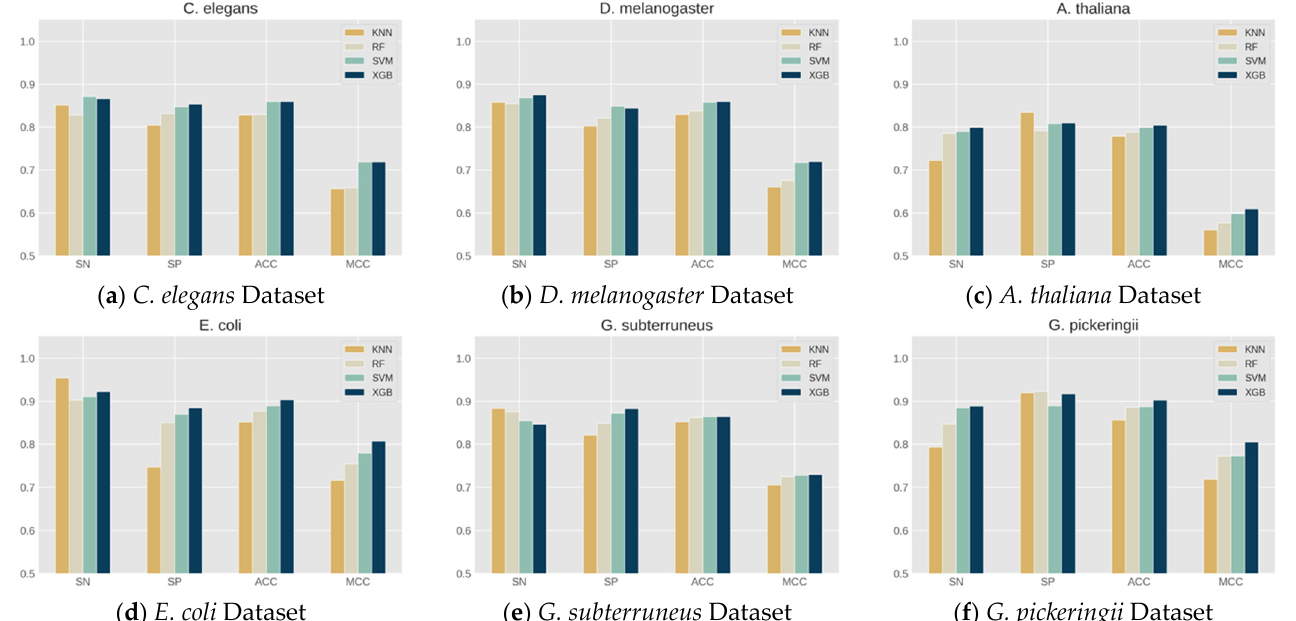
Figure 6. Performance comparison of XGBoost and other three machine learning algorithms on six benchmark datasets from multiple species.